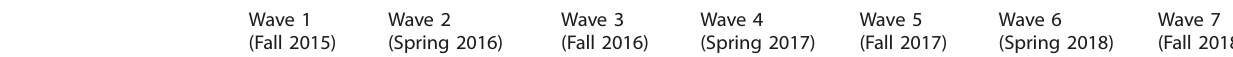
Table 1. Overview of study cohort demographics, behaviors and sleep characteristics across duration of